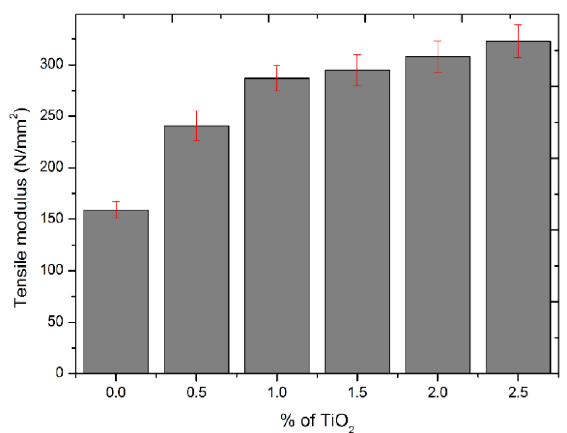
Fig. 6. Tensile modulus of Epoxy-TiO 2 nanocomposites at different concentrations